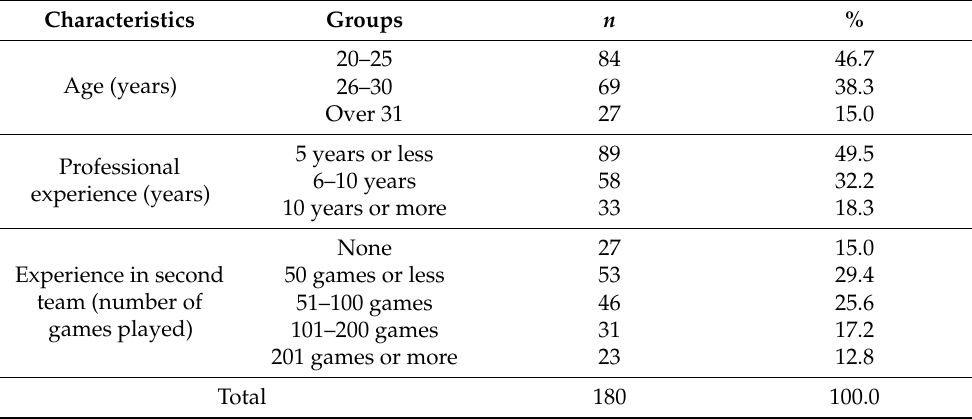
Table 1. Demographic characteristics of the participants.